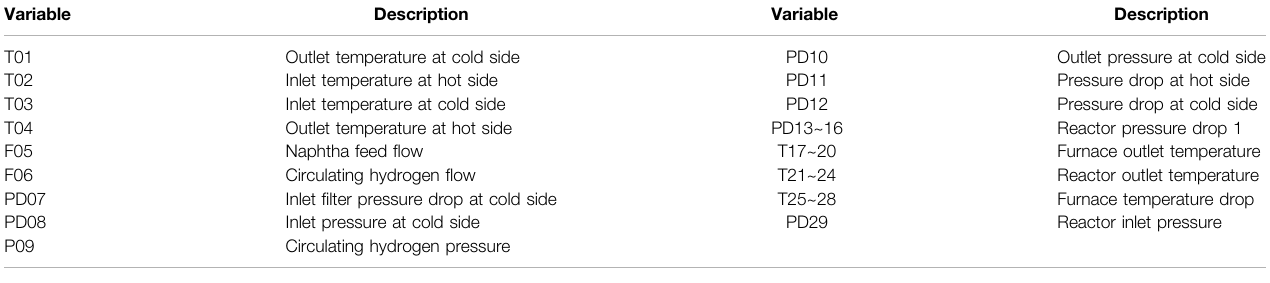
TABLE 5 | Process variables in the industrial continuous catalytic reforming unit.